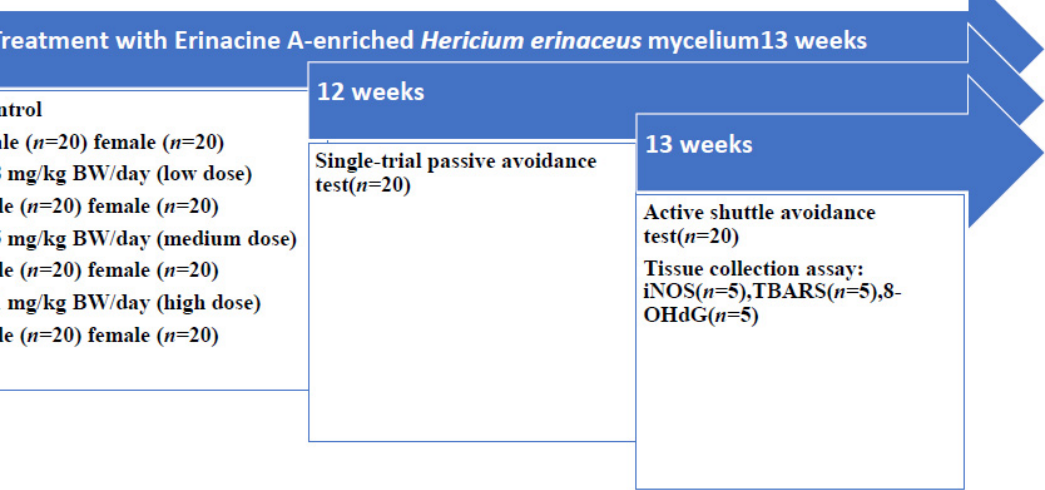
Figure 1. Schematic representation of the experimental design. Table 1. Single-trial passive avoidance latency time in mice after 12 weeks feeding.